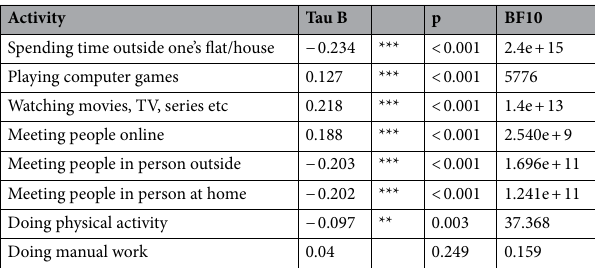
Table 2. Correlations between lifestyle habits and general perception that lockdown influenced one’s life. *** = significant at the 0.001 level, ** = significant at the 0.01 level, and * = significant at the .05 level